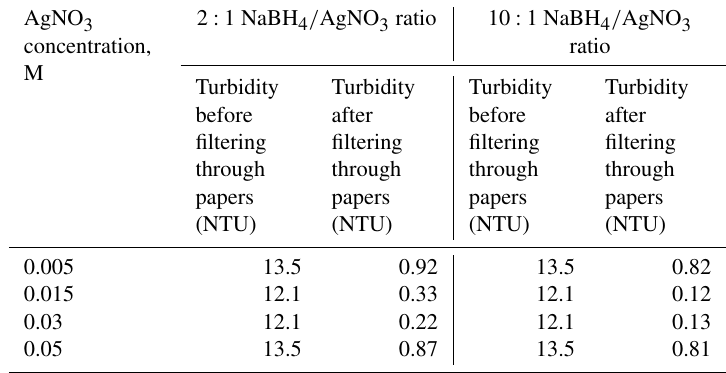
Table 5. Turbidity results before and after filtration through AgNP paper for both reduction ratios.